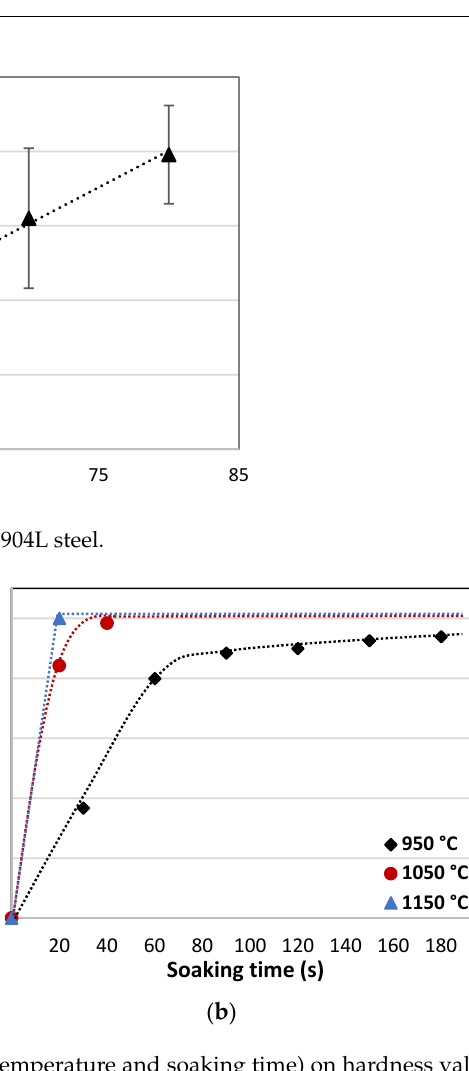
( a ) and recrystallized volume fraction (X v ) ( b ) of AISI 904L cold-rolled at 50%.